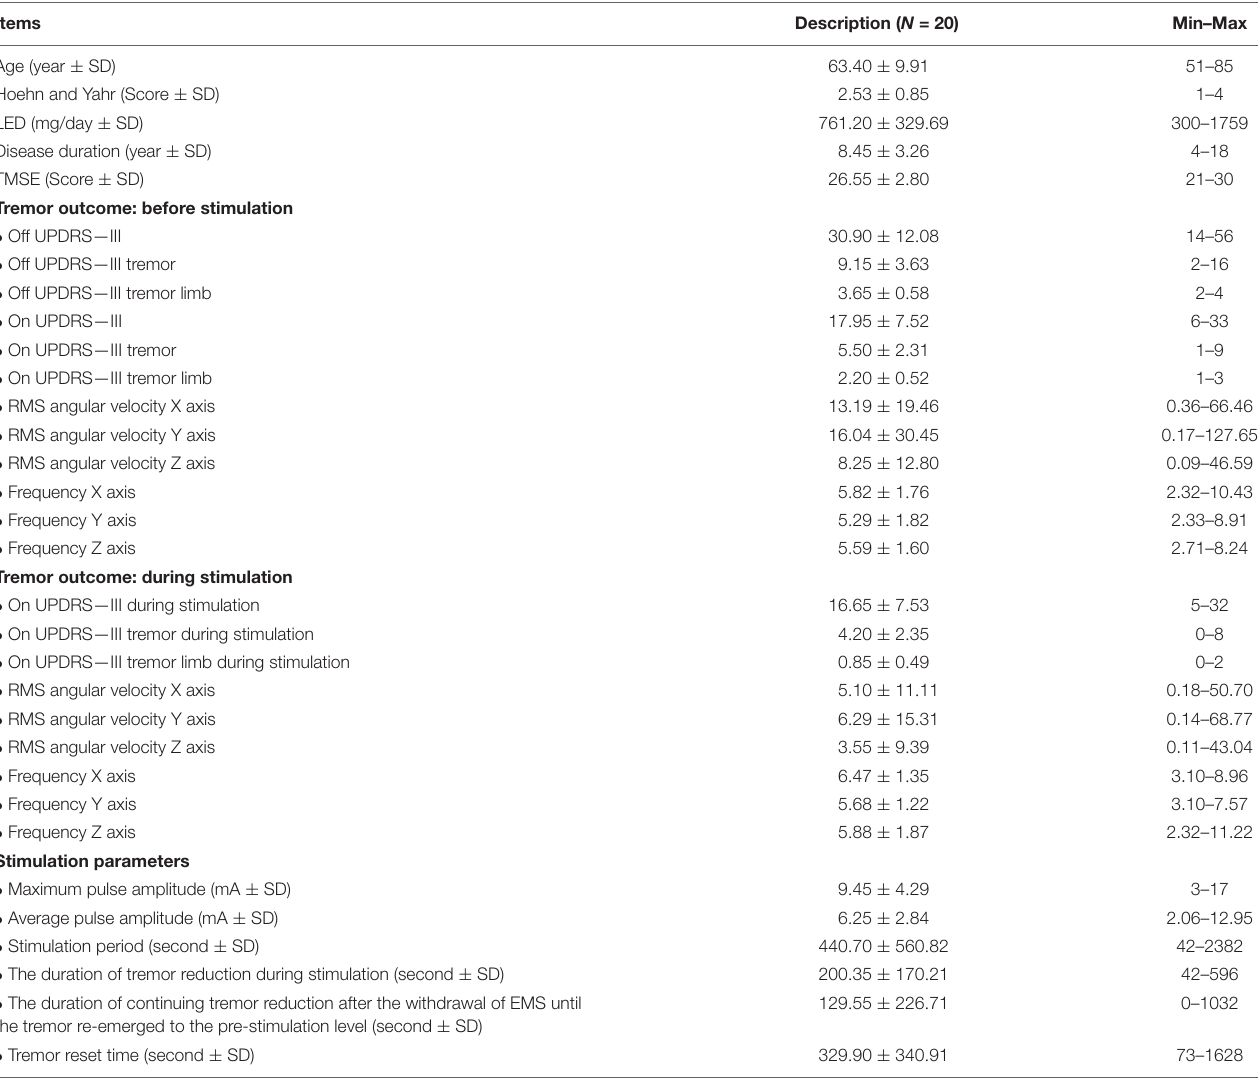
TABLE 3 | A demographic study of all patients participated in this study.